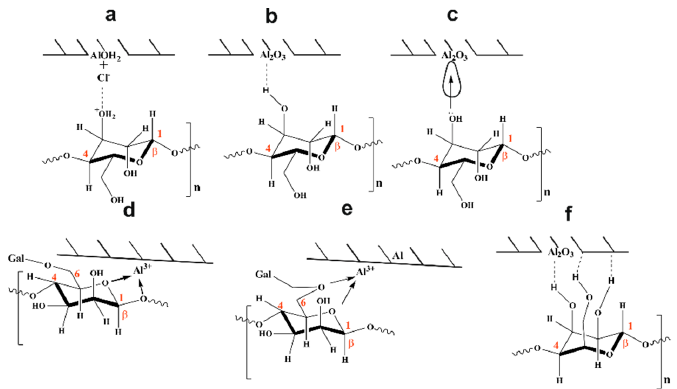
Figure 8. Schematic representation of possible adsorption models of GG on the aluminium surface in an acid medium: (a) electrostatic interaction with Cl − ions; (b) H-bond formation; (c) coordinate bond with the metal; (d,e) chelating action; and (f) horizontal orientation.